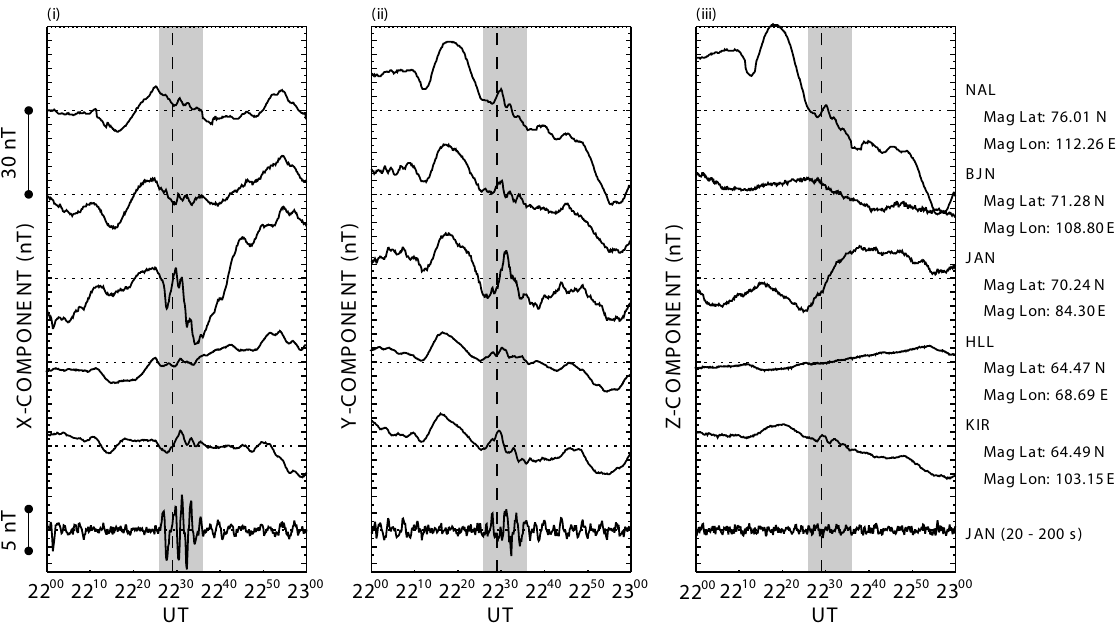
Fig. 4. X - Y - and Z -component magnetometer data from the five stations indicated in Fig. 1, for the interval 22:00–23:00 UT. The vertical dashed line and grey shaded area are as in Fig. 2, and the scale of the curves is shown on the left-hand side of the figure. The bottom curves show Pi2 filtered data (20–200s) from the JAN magnetometer, and have a separate scale as indicated. Station identifier codes and their locations are indicated on the right-hand